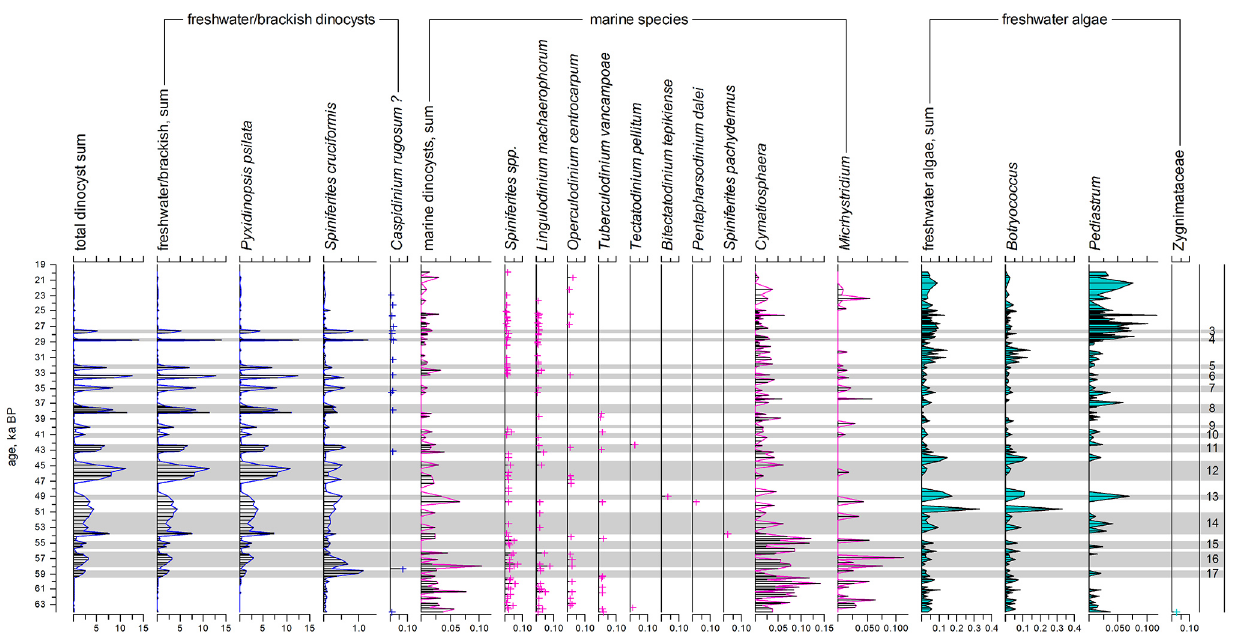
Fig. 4. Concentration diagram of dinoflagellate cysts, freshwater algae and acritarchs (specimens × 10 3 cm − 3 ) versus age. Horizontal grey bars with numbers indicate GI as identified by the 25-GC1 CaCO 3 (GI 17-5) and dinocyst (GI 4 and 3) records.